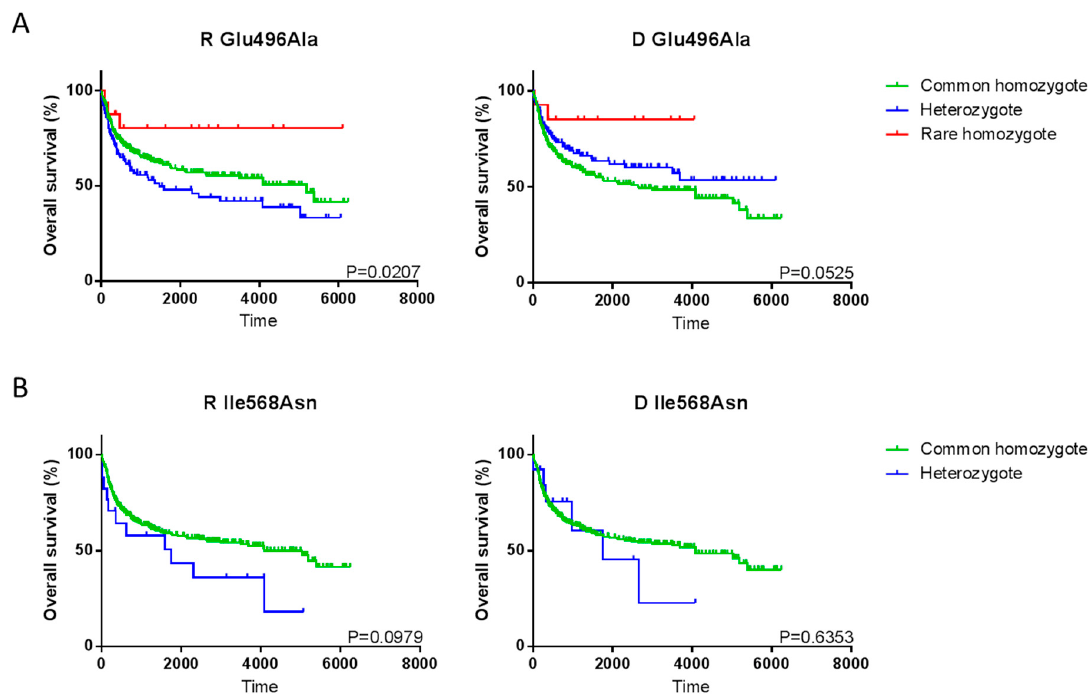
Figure 1. Association between Recipient (R) or Donor (D) Glu496Ala and Ile568Asn and overall survival using the Kaplan–Meier method. ( A ) Glu496Ala recipients (left, common homozygote n = 307, heterozygote = 129, rare homozygote = 16. One recipient SNP analysis failed and was excluded from analysis) and donors (right, common homozygote n = 302, heterozygote = 137, rare homozygote = 14). ( B ) Ile568Asn recipients (left, common homozygote n = 435, heterozygote = 17. 1 recipient SNP analysis failed and was excluded from analysis) and donors (right, common homozygote n = 437, heterozygote = 13. One donor was rare heterozygote and was excluded from analysis. Two donors SNP analysis failed and were excluded from analysis).